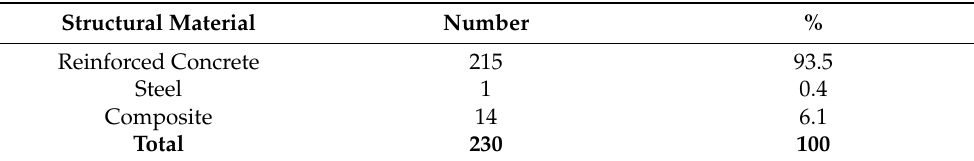
Table 5. Classification of selected tall buildings by structural material.